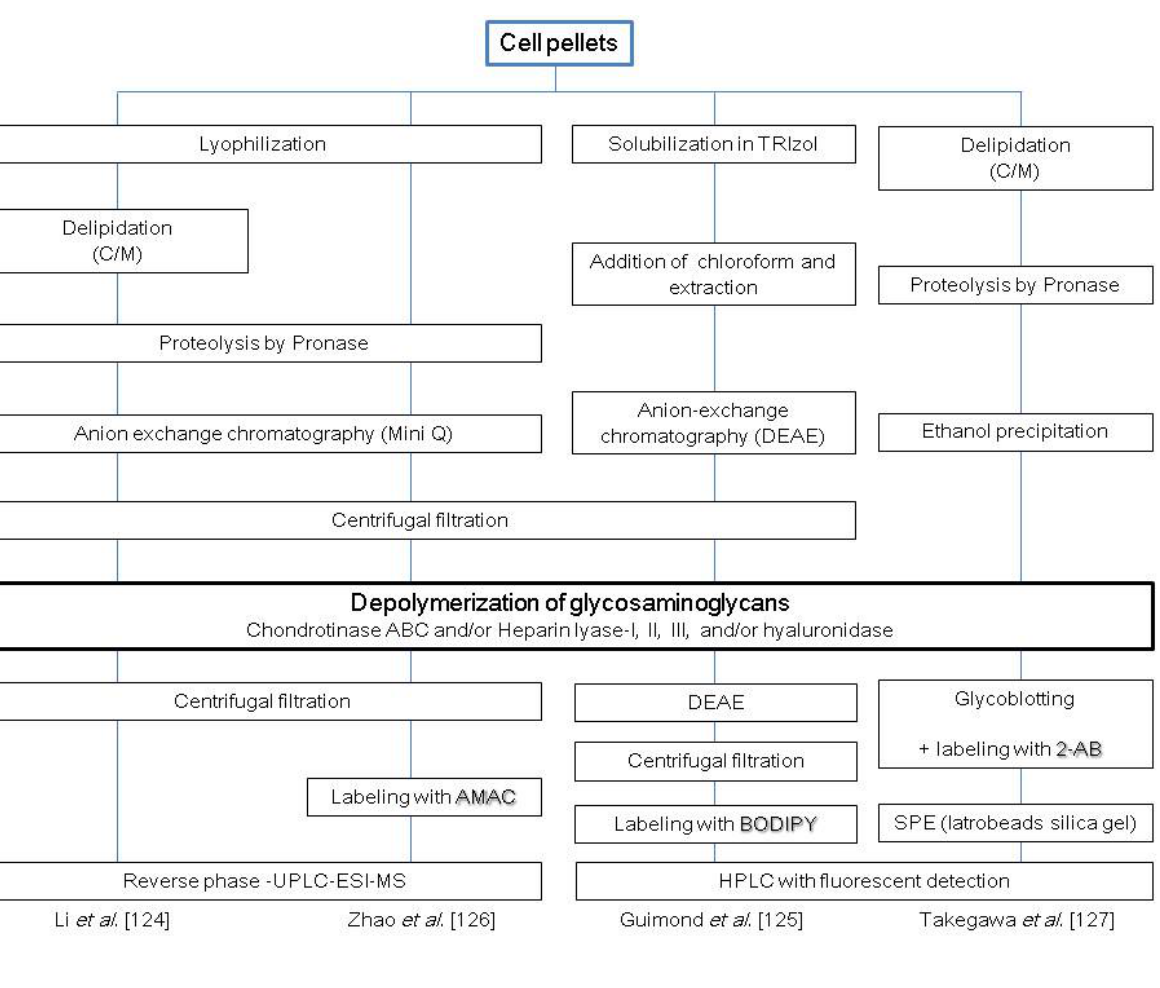
Scheme 4. Representative protocols for cellular glycosaminoglycans (GAG)